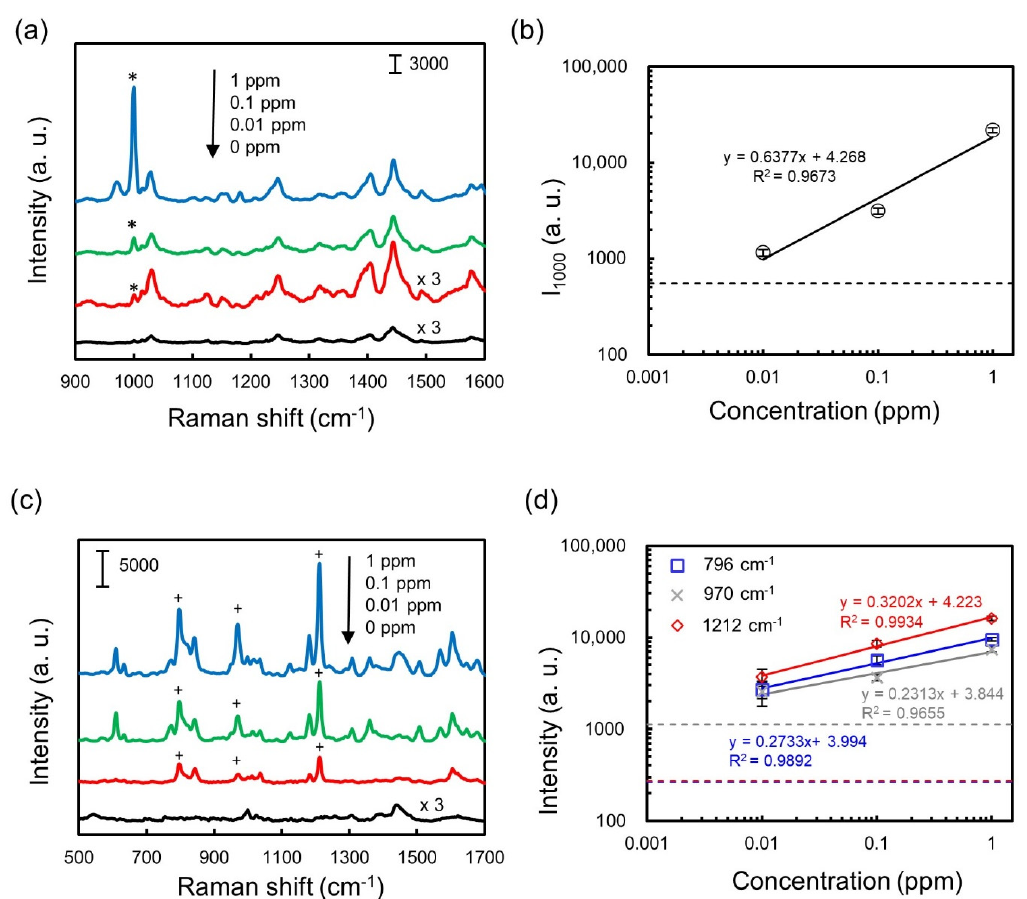
Figure 2. SERS detection of MC and 4-MMC in water. ( a,c ) SERS spectra of ( a ) MC and ( c ) 4-MMC in water with concentrations ranging from 0.01 to 1 ppm. The characteristic Raman peak of MC at 1000 cm − 1 and the characteristic Raman peak of 4-MMC at 1212 cm − 1 are marked with “*” and “+”, respectively. ( b ) A plot of the intensity of the 1000 cm − 1 peak versus MC concentration. Error bars show standard deviations with n = 30. The straight line is the linear regression line, and the dotted line indicates mean plus 3 standard deviations (mean + 3 σ , σ is the standard deviation) of the 1000 cm − 1 peak of the blank sample. ( d ) A plot of the intensities of the 796, the 970, and the 1212 cm − 1 peaks versus 4-MMC concentration. Error bars show standard deviations with n = 30. The straight lines are the linear regression lines, and the blue, gray, and red dotted lines indicate mean plus 3 σ of the 796, the 970, and the 1212 cm − 1 peaks, respectively, of the blank sample.